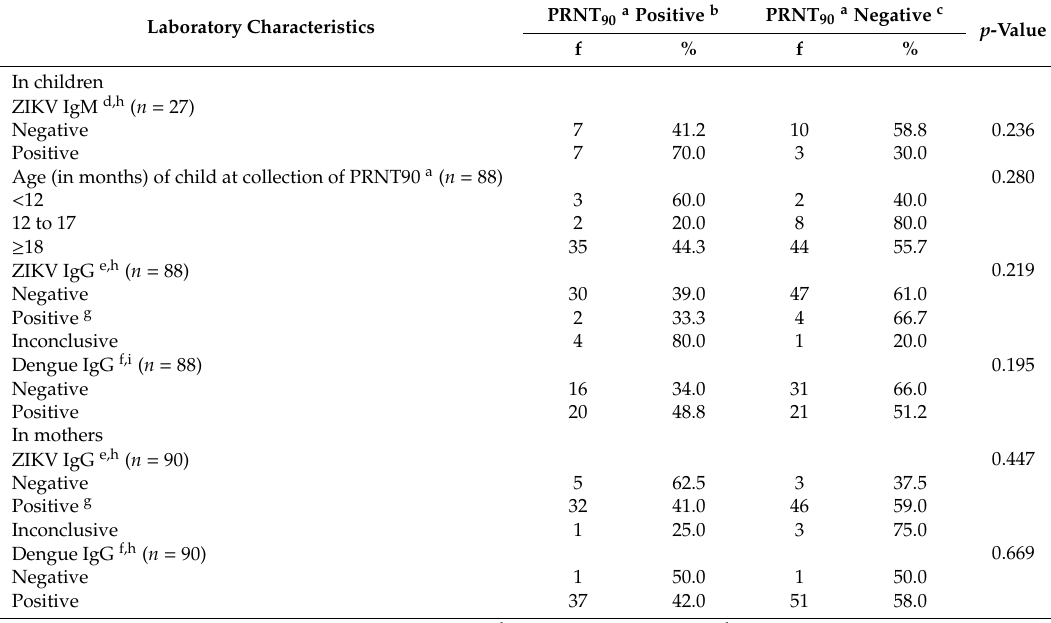
PRNT 90 a Positive b PRNT 90 a Negative c